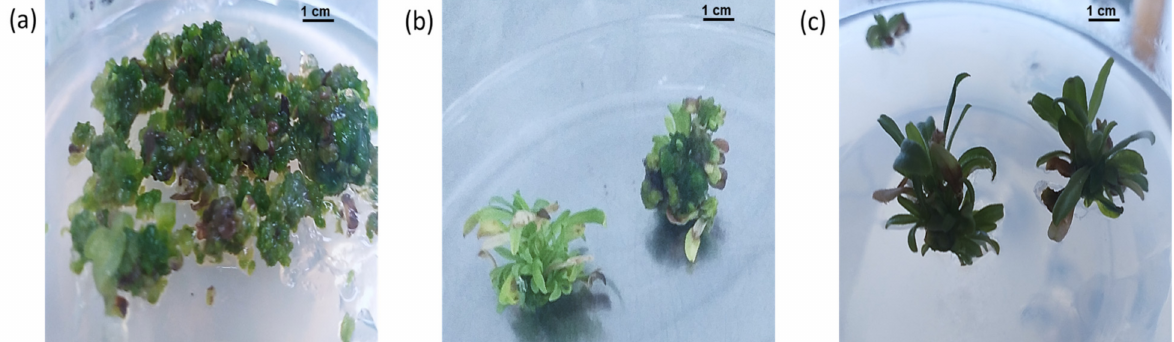
Figure 4. ( a ) C. montanus microshoots induction on MS medium supplemented with 8.8 µ M BAP, 2.2 µ M Zeatin, and 1.4 µ M GA 3 ; ( b ) Microshoots after four weeks of culture on MS medium supple- mented with 8.8 µ M BAP, 2.2 µ M Zeatin, and 1.4 µ M GA 3 ; ( c ) Microshoots growth on MS medium supplemented with 8.8 µ M BAP and 0.5 µ M NAA after four weeks of